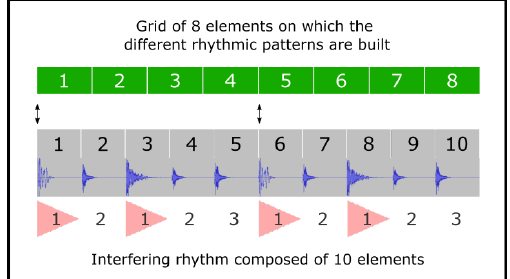
Figure 4. Coincidences and contrasts between visual rhythmic pattern grid (eight elements in green) and auditory rhythm (10 elements in gray). First and fifth beats of visual rhythm correspond to first and sixth beats of auditory rhythm, respectively (see black arrows), while other beats do not corre- spond. This alternation between coincidences and contrasts, in addition to irregular pattern of accents (red triangles), was conceived to induce users into error when synchronizing with visual